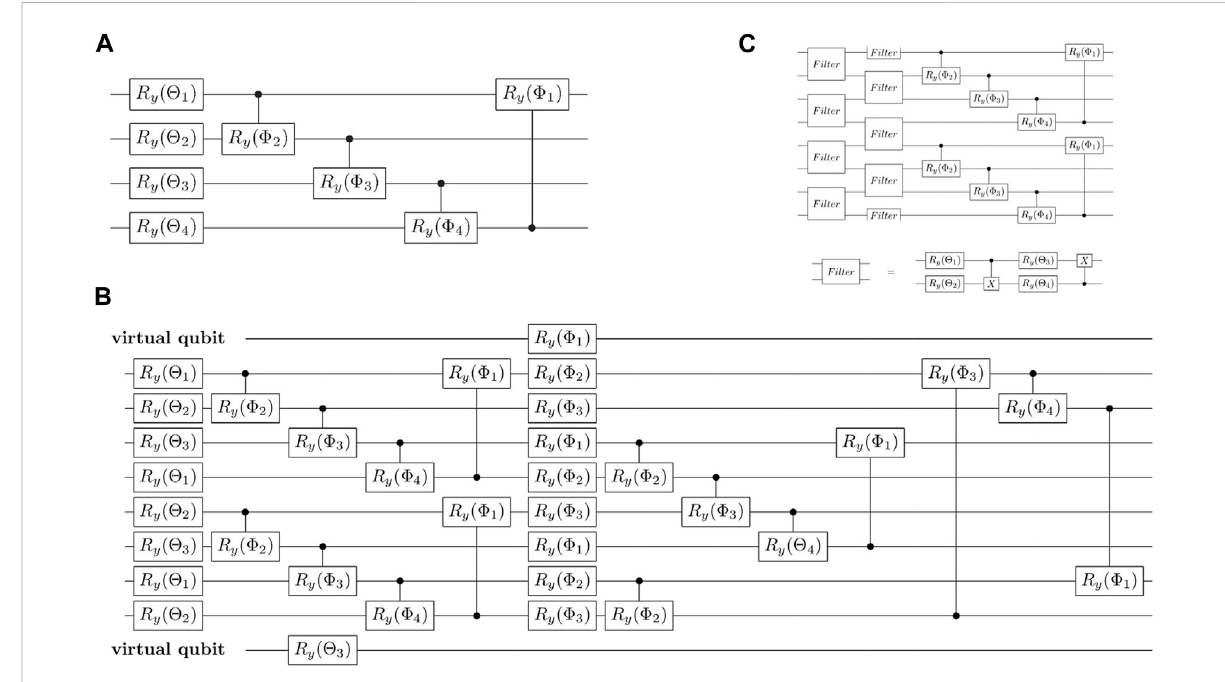
FIGURE 2 Quantum circuits for preliminaryscanning:In (A) the4-qubit fi lterwith 4-qubit entanglementisshown; in (B) thestack of 3-qubit fi lterswith 4- qubit entanglement is presented; in (C) the 2-qubit fi lters with 4-qubit entanglement is